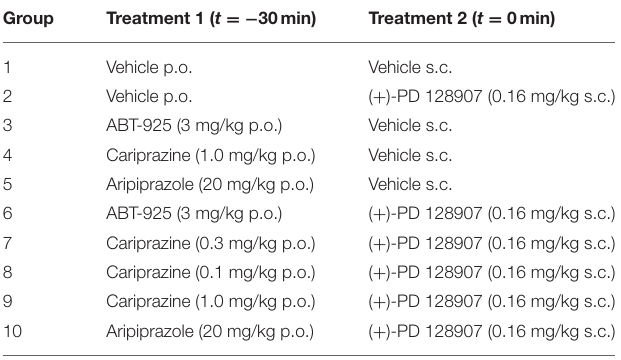
TABLE 1 | The doses and the order of the test compounds for the huddling study.